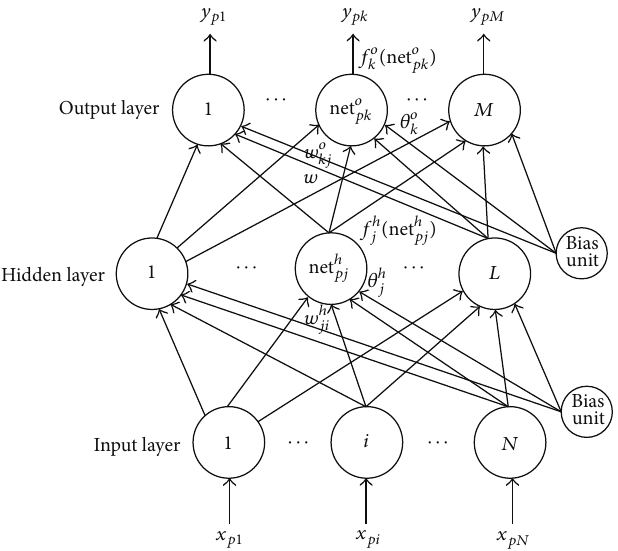
Figure 7: A three layer feed-forward backpropagation network